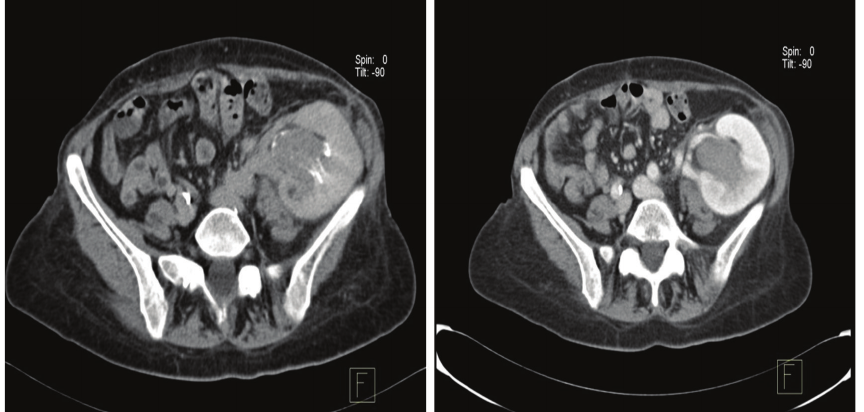
Figure 2: Pelvic CT demonstrating the presence of a big mass in the allograft, located in left iliac fossa, affecting renal pelvis and calyx.